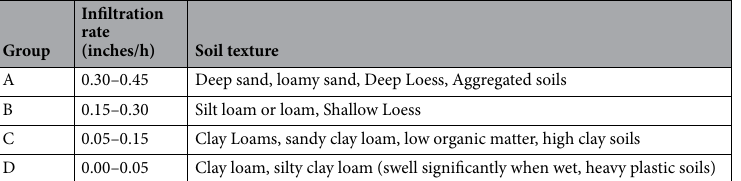
Table 1. Soil groups as classified by USDA